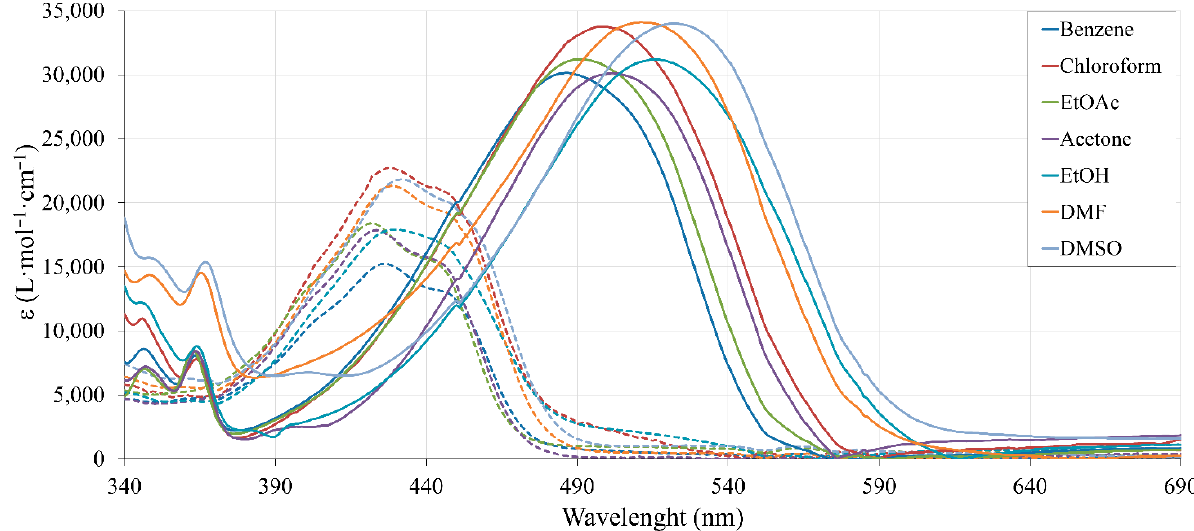
Molecules 2021 , 26 , x FOR PEER REVIEW Figure 5. The absorption spectra of azomethine 2c (dashed lines) and amine 3c in various organic solvents.